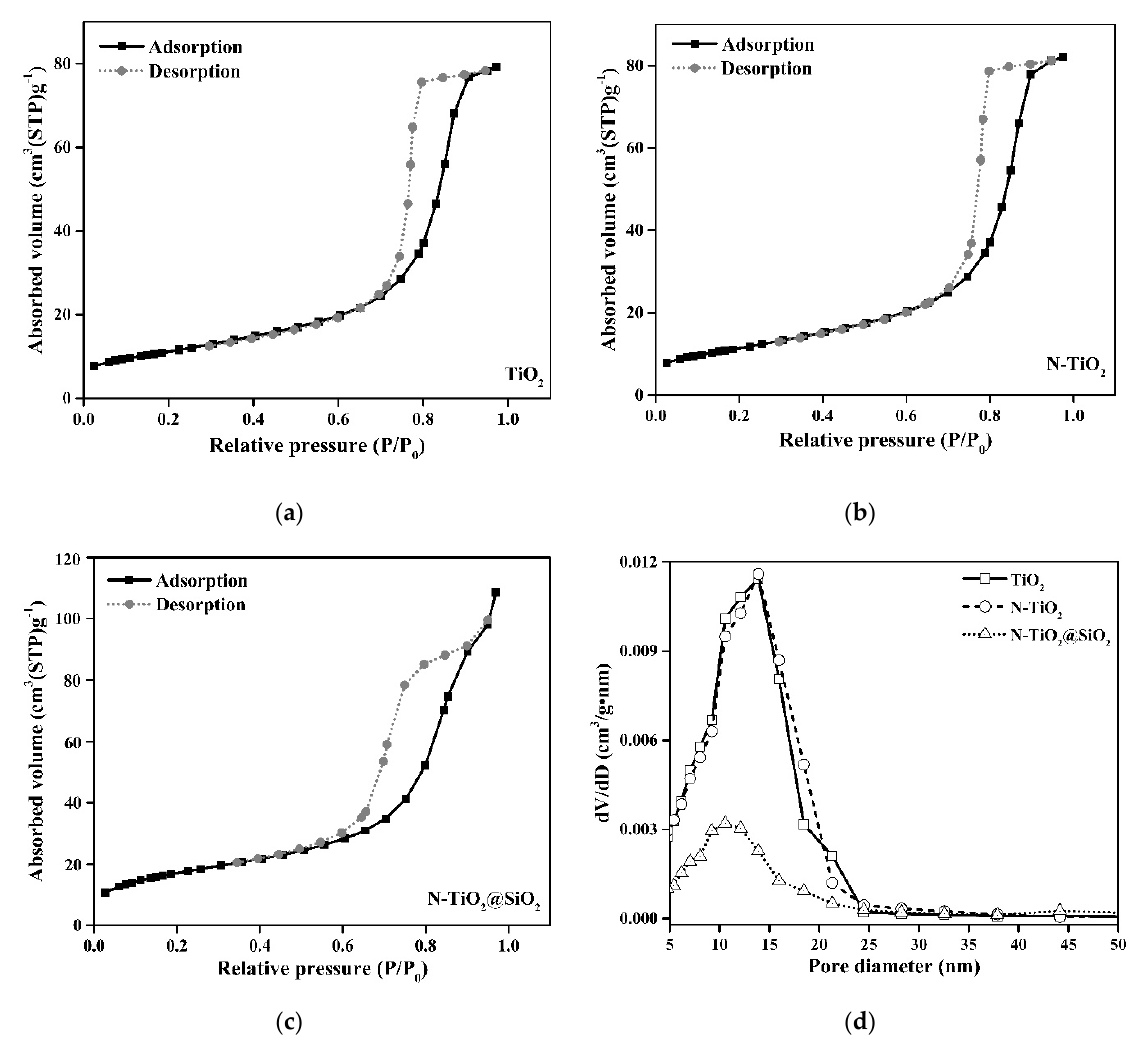
Figure 4. N 2 adsorption-desorption isotherms of ( a ) TiO 2 , ( b ) N-TiO 2 , ( c ) N-TiO 2 @SiO 2 core/shell, and ( d ) pore size distribution.